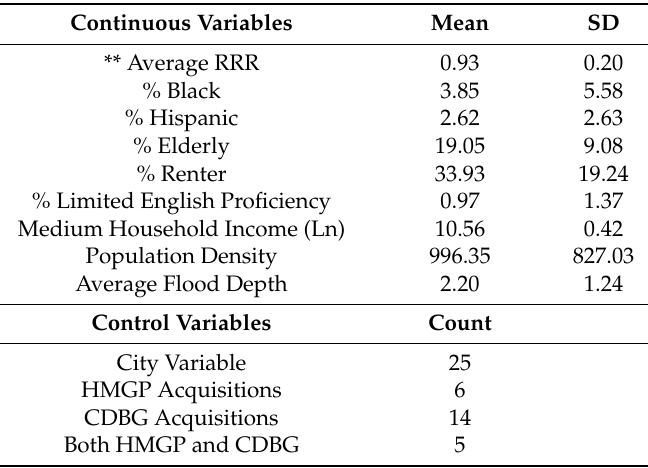
Table 4. Descriptive statistics for model